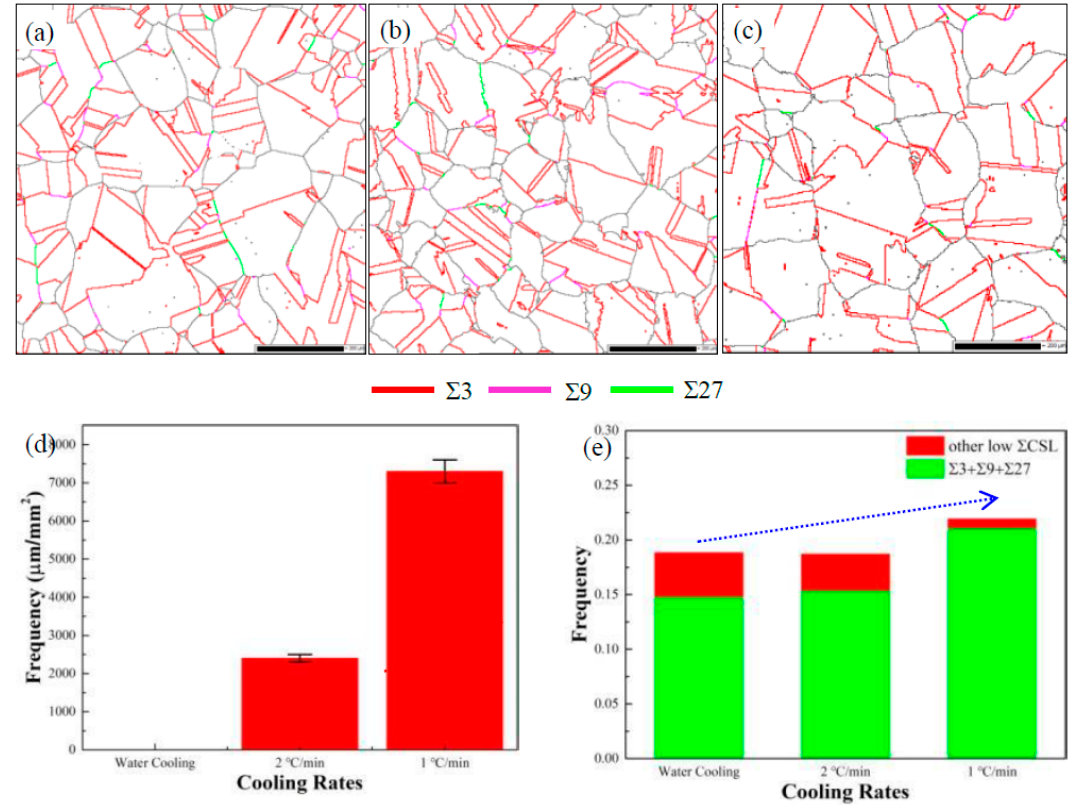
Figure 9. CSL maps for the specimens under different cooling rates. ( a ) Water-quenched, ( b ) 5 °C/min, ( c ) 1 °C/min, ( d ) the frequency of serrated grain boundaries, ( e ) the frequency of the low Σ CSL boundaries.